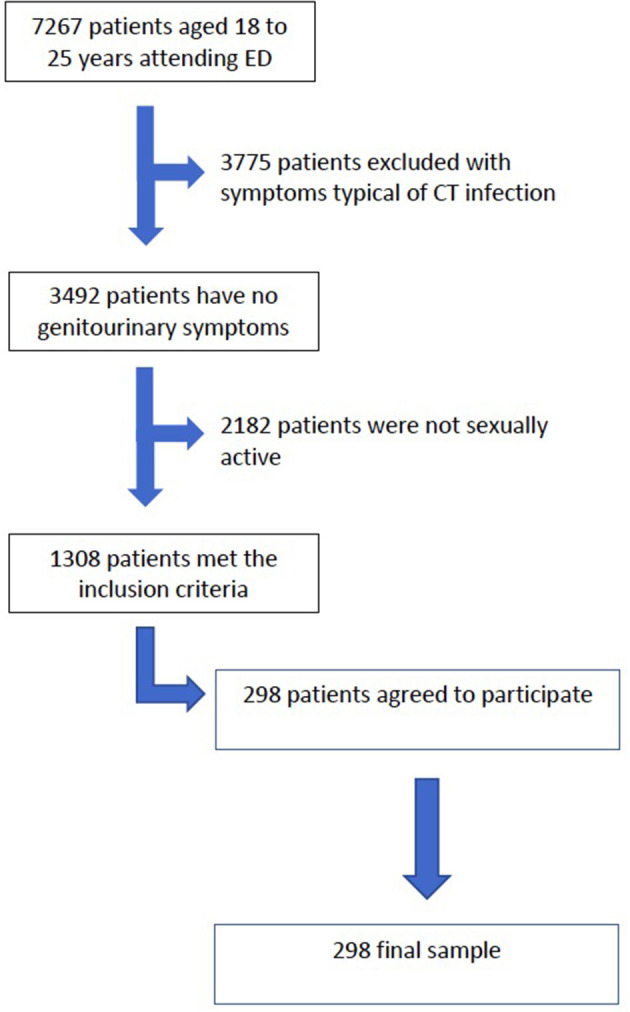
Flowchart of patient inclusion.